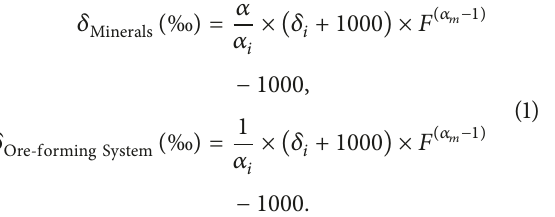
liquid inclusions (L type), and C pure CO 2 inclusions (PG type) [104] from Zhaxikang